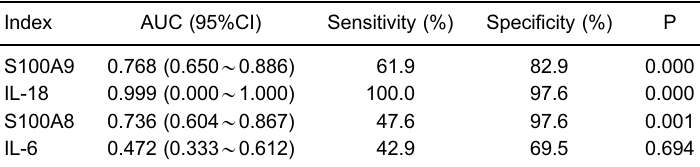
Figure 3. Relationship between serum concentra- tions of IL-6 and IL-18 and the presence ( + ) or absence (-) of joint damage. Data are reported as means ± SD. IL: interleukin. One-way ANOVA was used for statistical